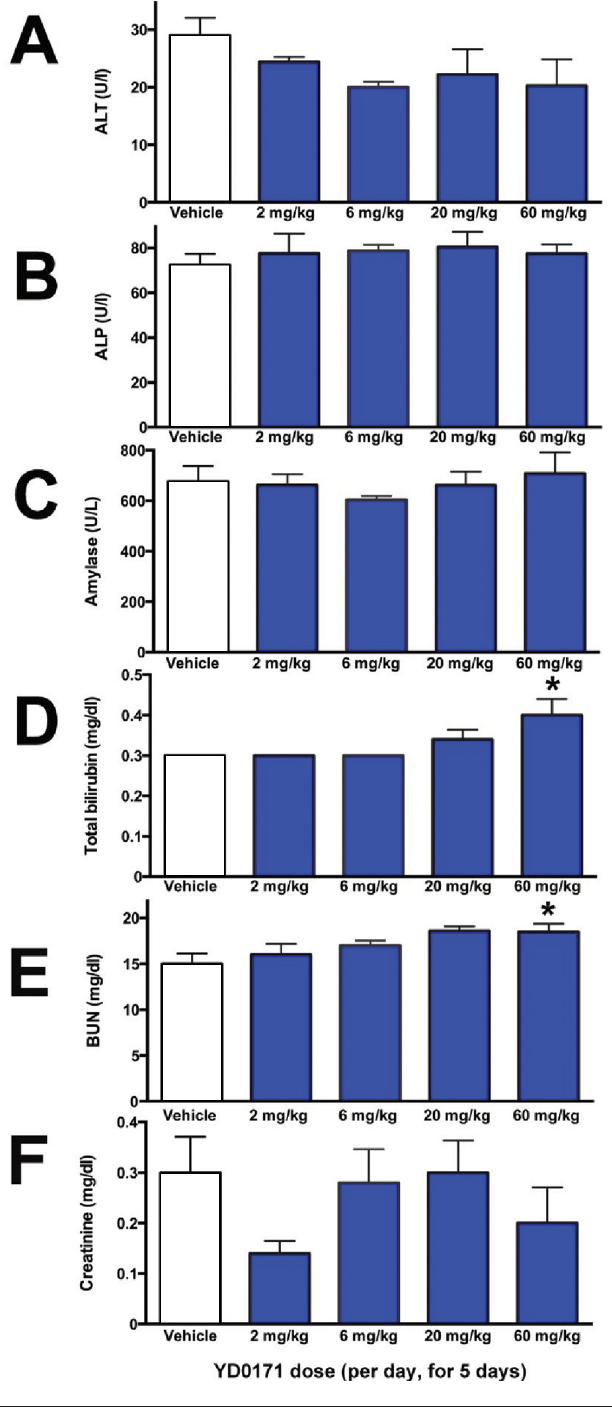
Figure 19. Effect of YD0171 treatment on plasma markers of organ damage in mice. Mice were subjected to intraperitoneal injection of YD0171 in two divided doses (total daily doses: 2, 6, 20 and 60 mg/kg/d) for five consequent days. On the morning of the sixth day, animals were killed and blood was collected and analyzed by the Vetscan system. Data are shown as mean ± SEM of n = 5 mice per group; * p < 0.05 indicates a significant effect of YD0171 compared with vehicle